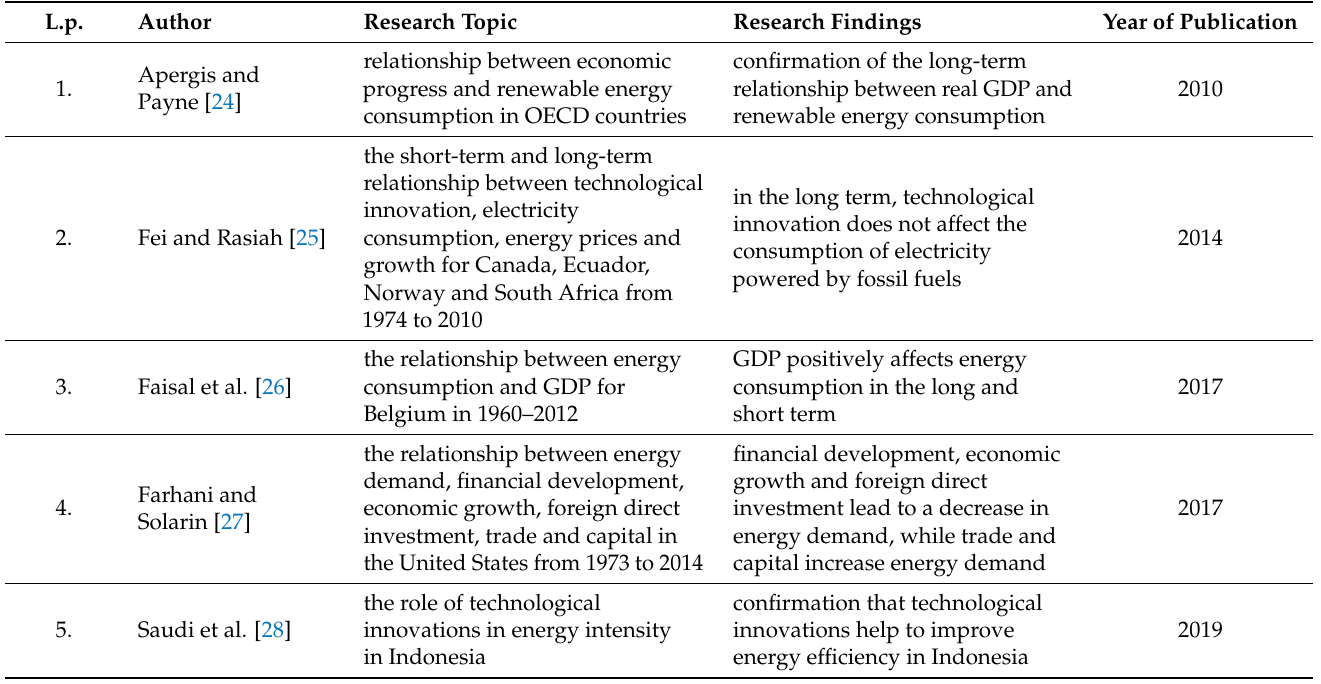
Table 2. Selected research in the energy area using the ARDL